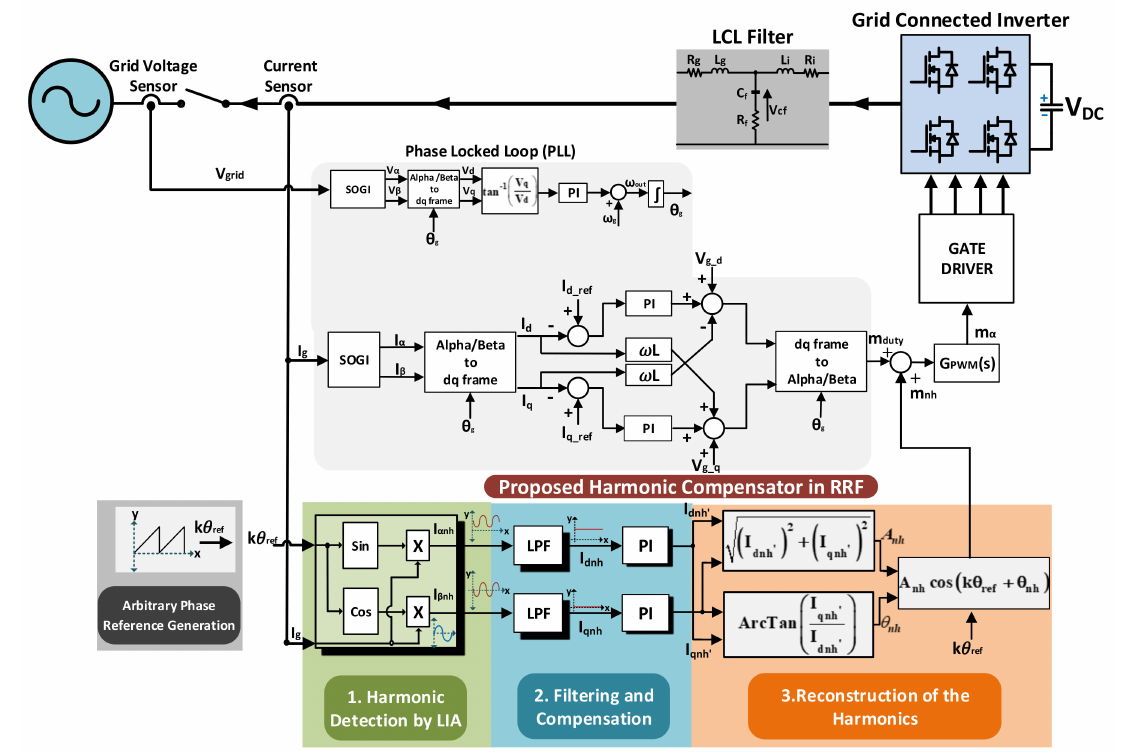
Figure 3. Block diagram of the proposed harmonic compensation method in the